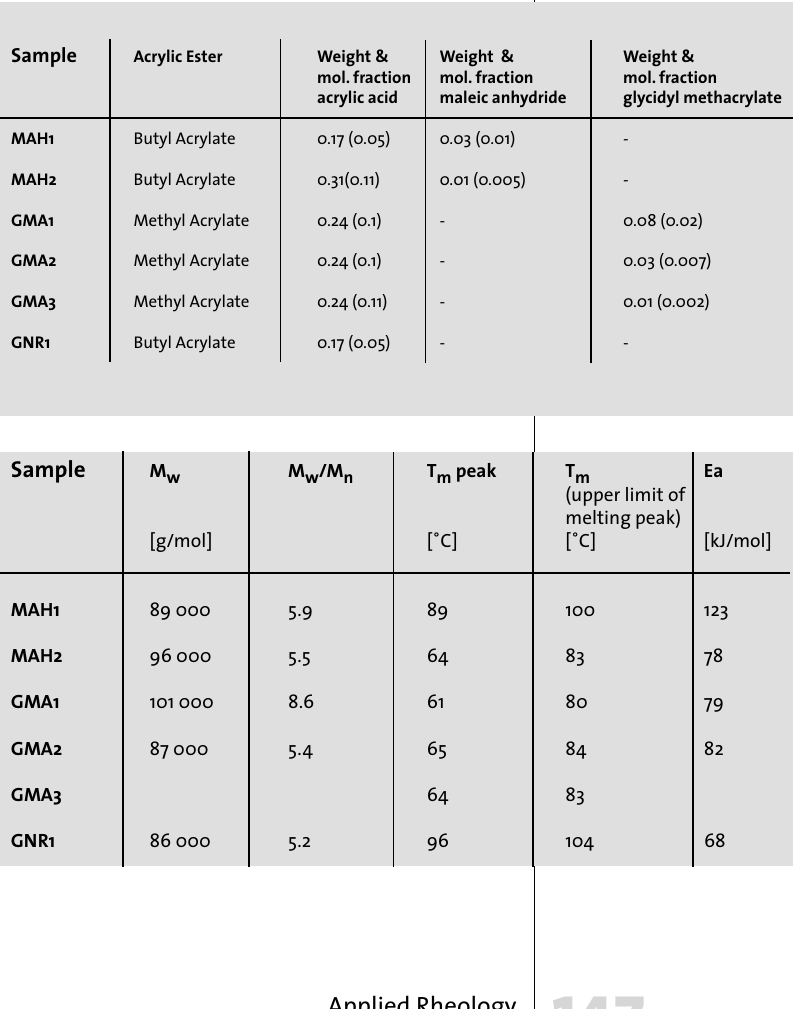
Table 3 (above): Composi- tion of reactive terpolymers and non reactive copolymer. Table 4 (below): Weight average molecular weight and polydispersity index determined by SEC in trichlorobenzene at 145°C. Temperature at the melting